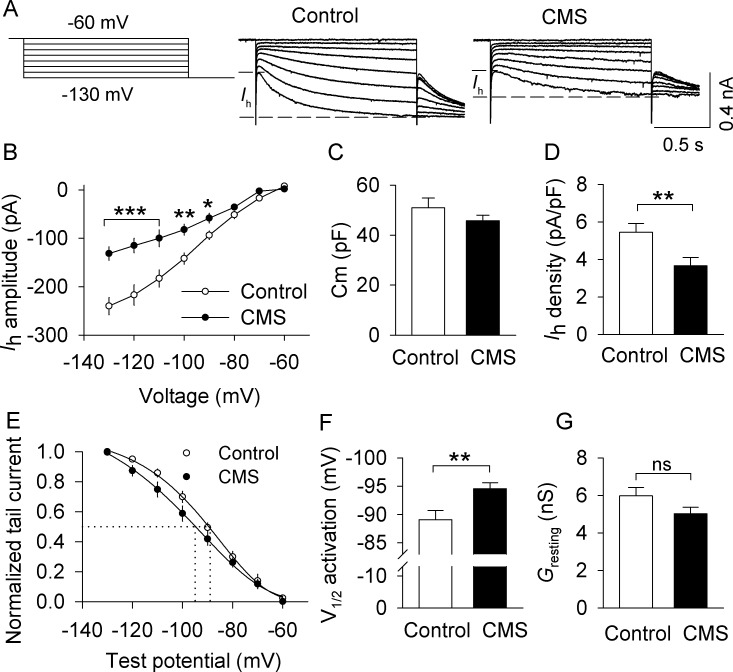
CMS decreased Ih currents in VTA dopamine neurons that project to the lateral shell of the NAc (LAcbSh).(A) Left: Voltage protocol for recording Ih current. Right: Representative Ih current recorded from NAc-projecting VTA dopamine neurons in control and CMS mice. (B) Compared with the control group, Ih amplitude was significantly decreased in the CMS group at corresponding hyperpolarization potentials (*p<0.05, **p<0.01, ***p<0.001, control, n = 15 cells from five mice; CMS, 13 cells from three mice from B to G). Ih amplitude was calculated by subtracting the instantaneous current from the steady-state current achieved during the voltage step. (C) The membrane capacitance (Cm) was not significantly different between control and CMS mice (p=0.273). (D) Ih current density was significantly decreased in the CMS group compared with the control group (**p=0.009). (E) Ih activation curves in the control and CMS groups generated by the tail current protocol. Tail current amplitudes were fitted with a Boltzmann function. (F) CMS led to a significant hyperpolarizing shift of the half-activation potential (V1/2) compared with that of control (**p=0.007). (G) The resting membrane conductance (Gresting) was not significantly different between control and CMS mice (p=0.107).10.7554/eLife.32420.010Figure 4—source data 1.Ih amplitude and activation properties in VTA dopamine neurons following CMS in Figure 4B–G.